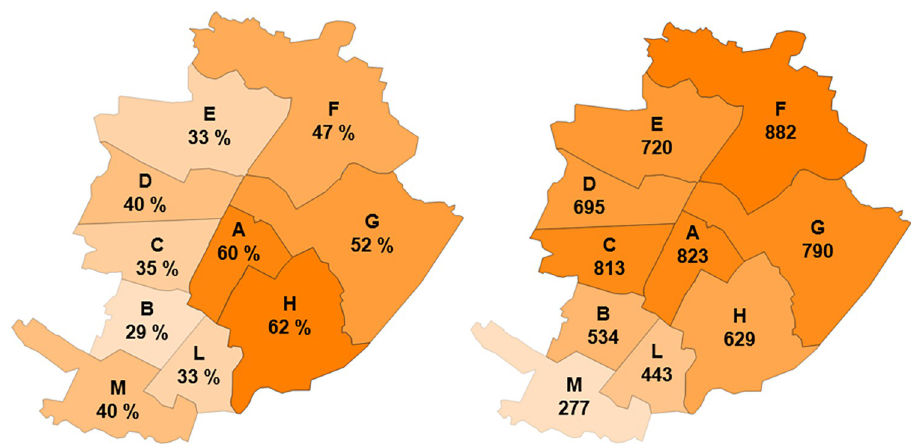
Fig 5. Domestic use of rainwater. Left: water saving efficiency. Right: average annual volumes of saved water (thousands of m 3 per year).